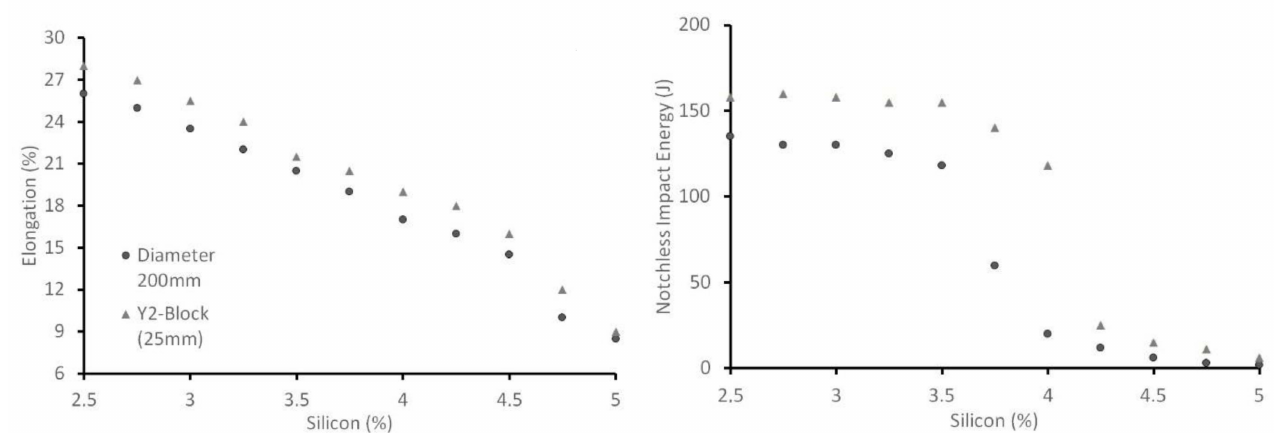
Figure 1. Impact and elongation with temperature for high silicon iron (HSI). Adapted from